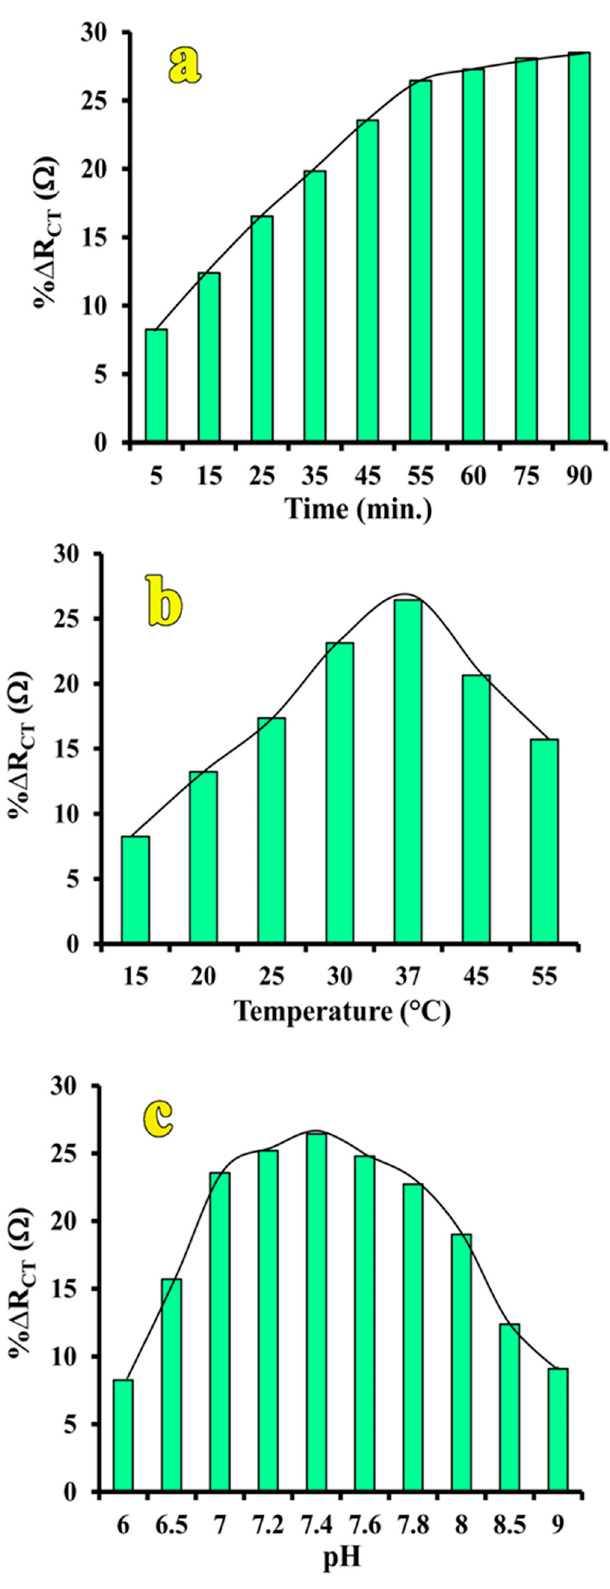
Figure 3. Optimization of the immunoreaction conditions: ( a ) time, ( b ) temperature and ( c ) pH. To optimize the immunoreaction temperature, the temperature was changed from 15 to 55 °C. As can be seen in Figure 3b, % ∆ R CT increased with the increase in temperature to 37 °C and then started to decrease. This suggested that the formation of immunocomplex at higher temperatures decreases in comparison with physiological temperature, related to a possible denaturation of the